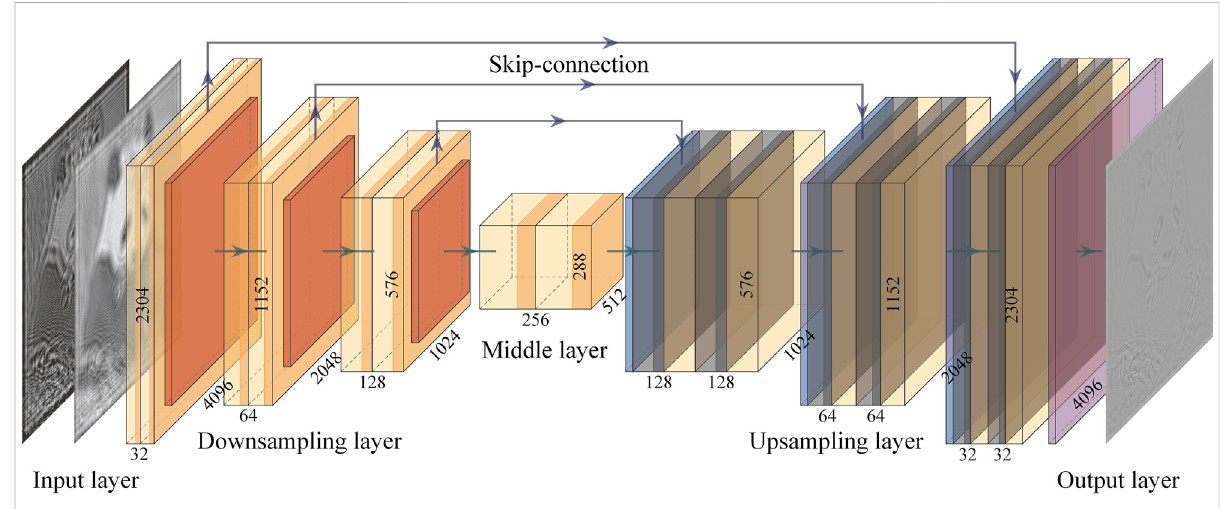
FIGURE 1 Structure of the U-Net-based neural